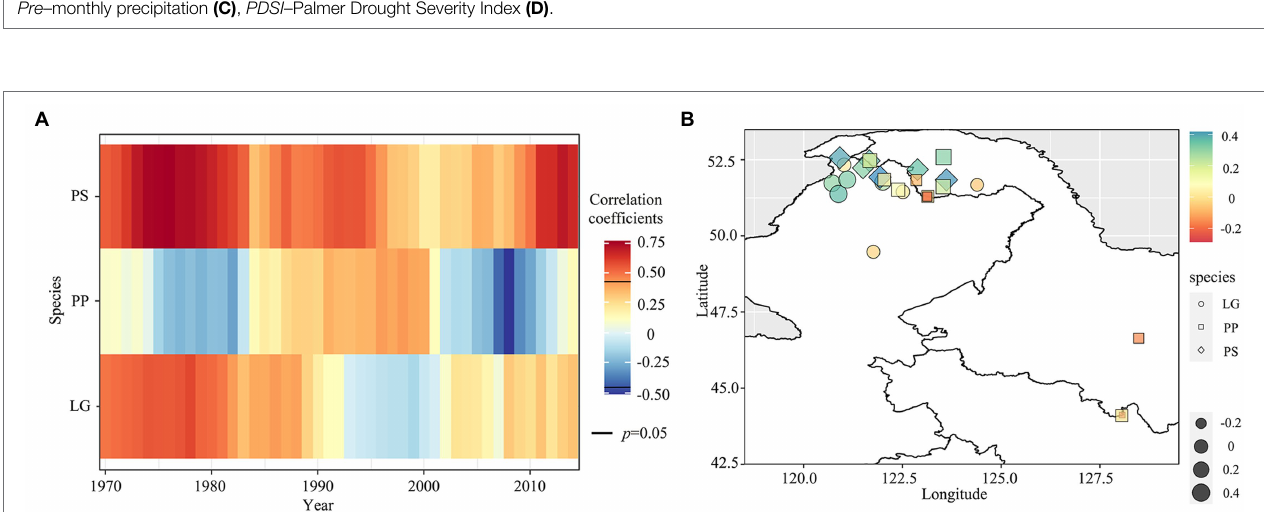
FIGURE 4 | Pearson correlation of ring-width index with monthly climate data from previous November (lower case n) to current October (upper case O) during 1950–2014. Horizontal dashed lines indicate the 95% significance levels. T max –monthly maximum temperature (A) , T min –monthly minimum temperature (B) , Pre –monthly precipitation (C) , PDSI –Palmer Drought Severity Index (D) .